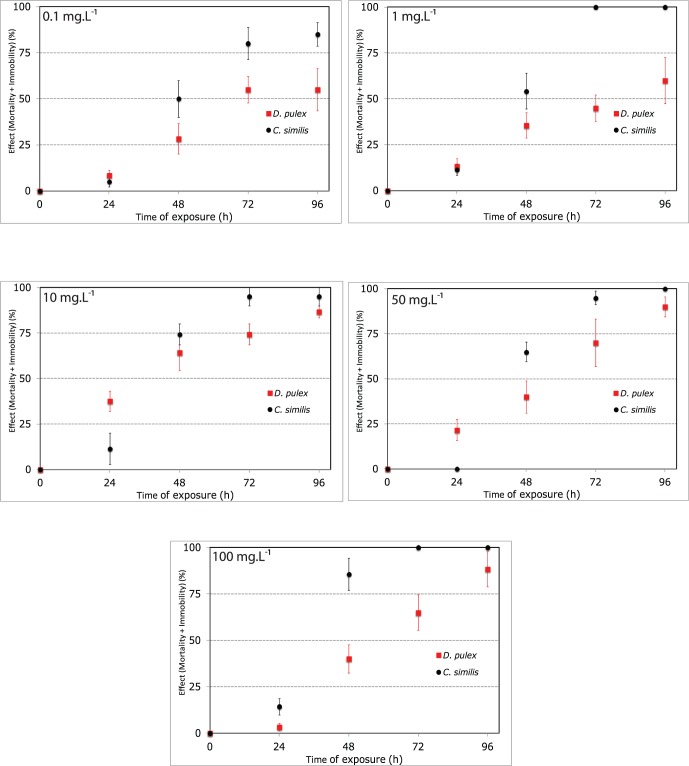
Effect curve vs time of D. similis and D. pulex at 0.1 mg.L−1, 1 mg.L−1, 10 mg.L−1, 50 mg.L−1 and 100 mg.L−1 of CeO2 NPs.Values are Mean EC50±SD.